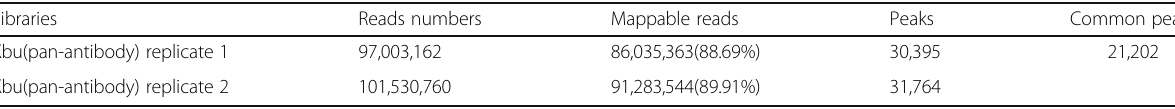
Table 1 Summary of ChIP-seq data